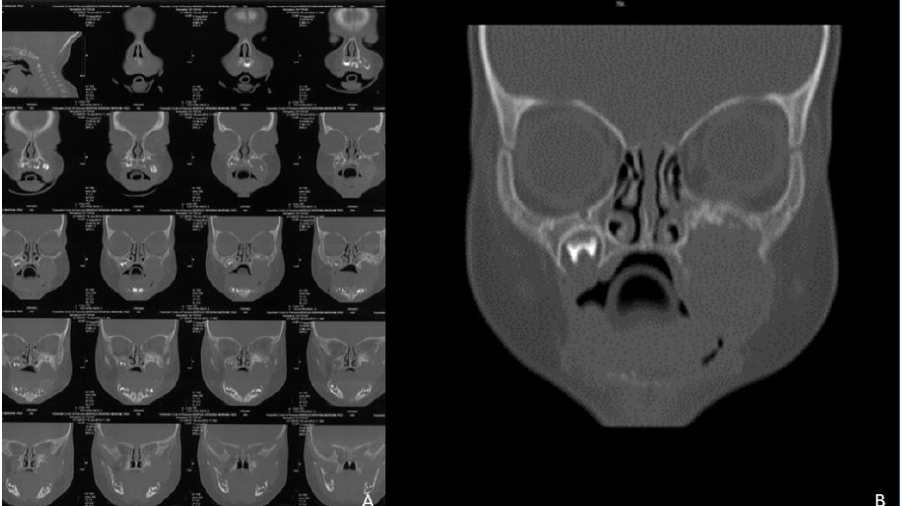
Figure 2. ( A , B ): Cone-beam of the maxillofacial region at 40 days of age. In the here-presented clinical case, the removal of a neoformation from the left upper jaw was performed at the Department of Maxillofacial Surgery at the University of Padua. The neoformation extended widely over much of the left upper jaw, all the way to the lower orbital fissure and the medial fossa of the skull and required removal of both the 26 and 27 tooth